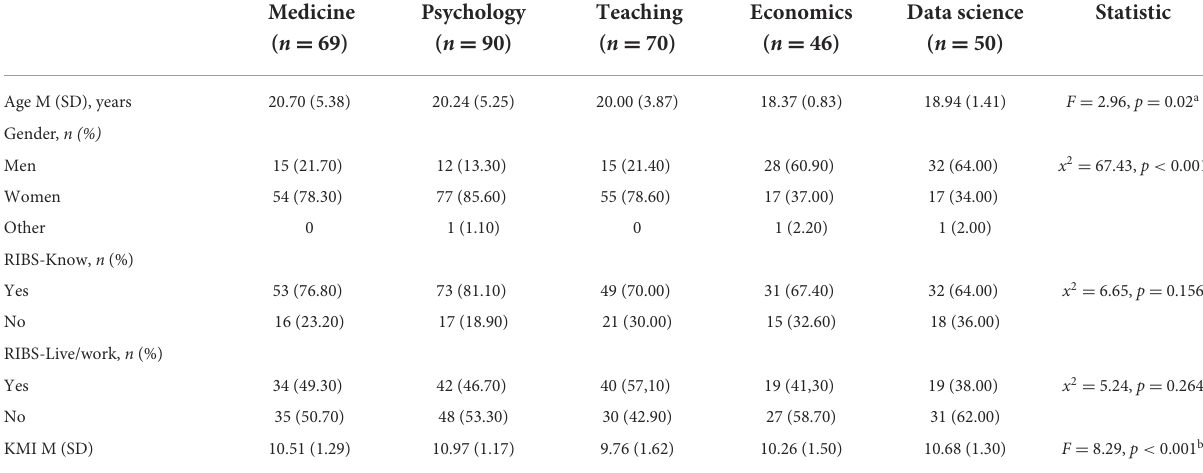
TABLE 1 Demographic characteristics and scores in the KMI and RIBS in the five university degrees.